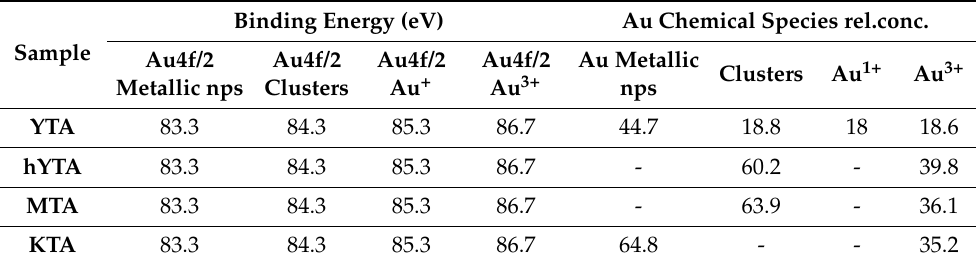
Table 1. XPS data: binding energies (BEs) and the quantitative assessment.